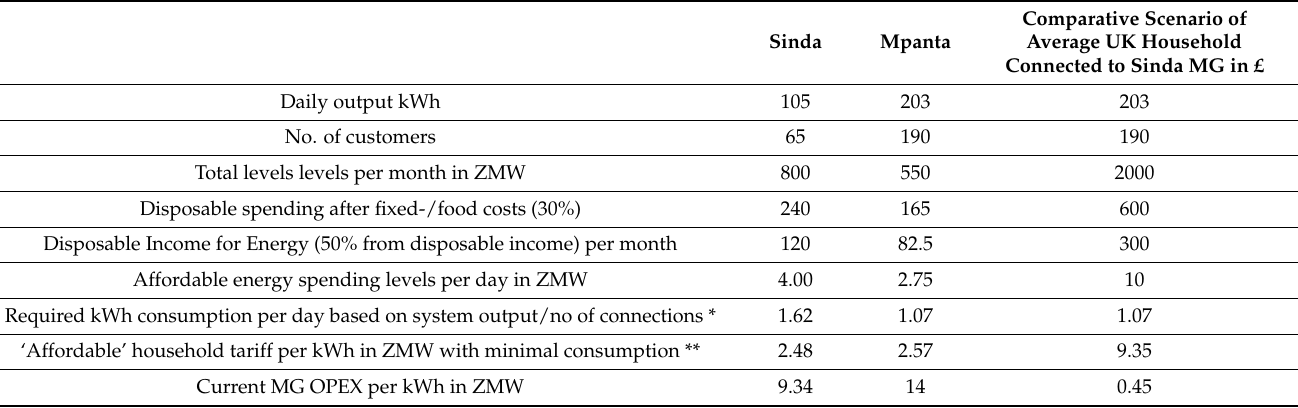
Table 8. MG energy-tariff affordability estimation for Mpanta and Sinda MG sites and comparison to UK household scenario based on household income and spending